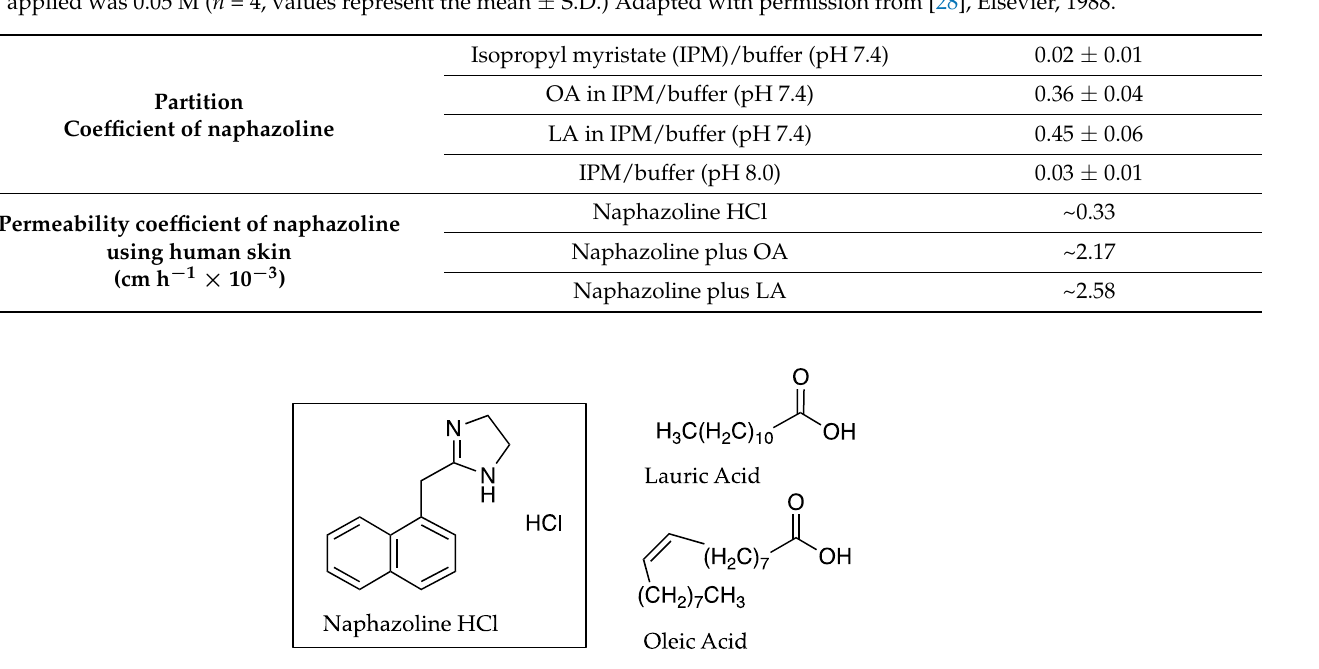
Figure 2. Naphazoline HCl and the counter ions LA and OA. Positive linear relationships were also found between experimental PC values of lignocaine HCl (0.19, 0.40 and 6.76) and corresponding flux values (1.2 ± 1.2, 13.0 ± 2.0 and 118.0 ± 30.0 µ g cm − 2 h − 1 ) through human skin, as seen in Table 2 [29]. Table 3